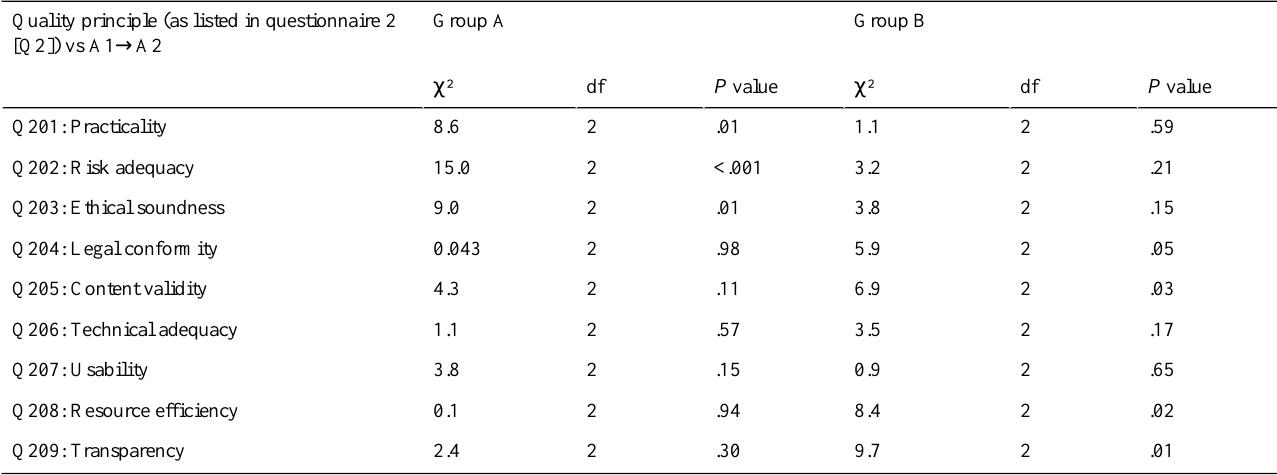
Table 13. Assessment of whether there was sufficient information matching the nine quality principles versus changes in assessment: initial to intermediate assessment (ie, changes from A1 a to A2 b toward a more critical assessment).